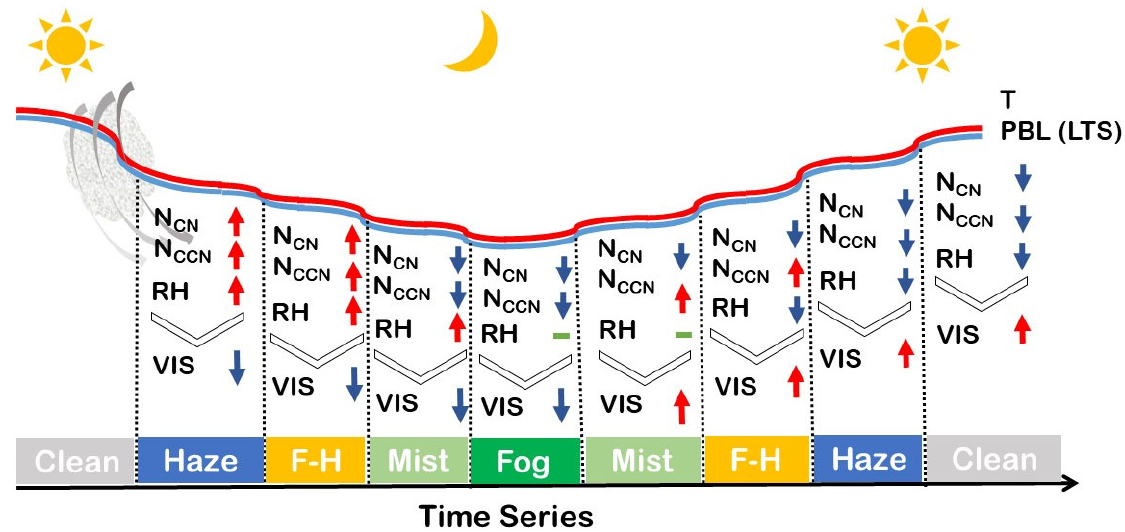
Figure 7. Conceptual model showing how the low ‐ visibility events evolve with time.